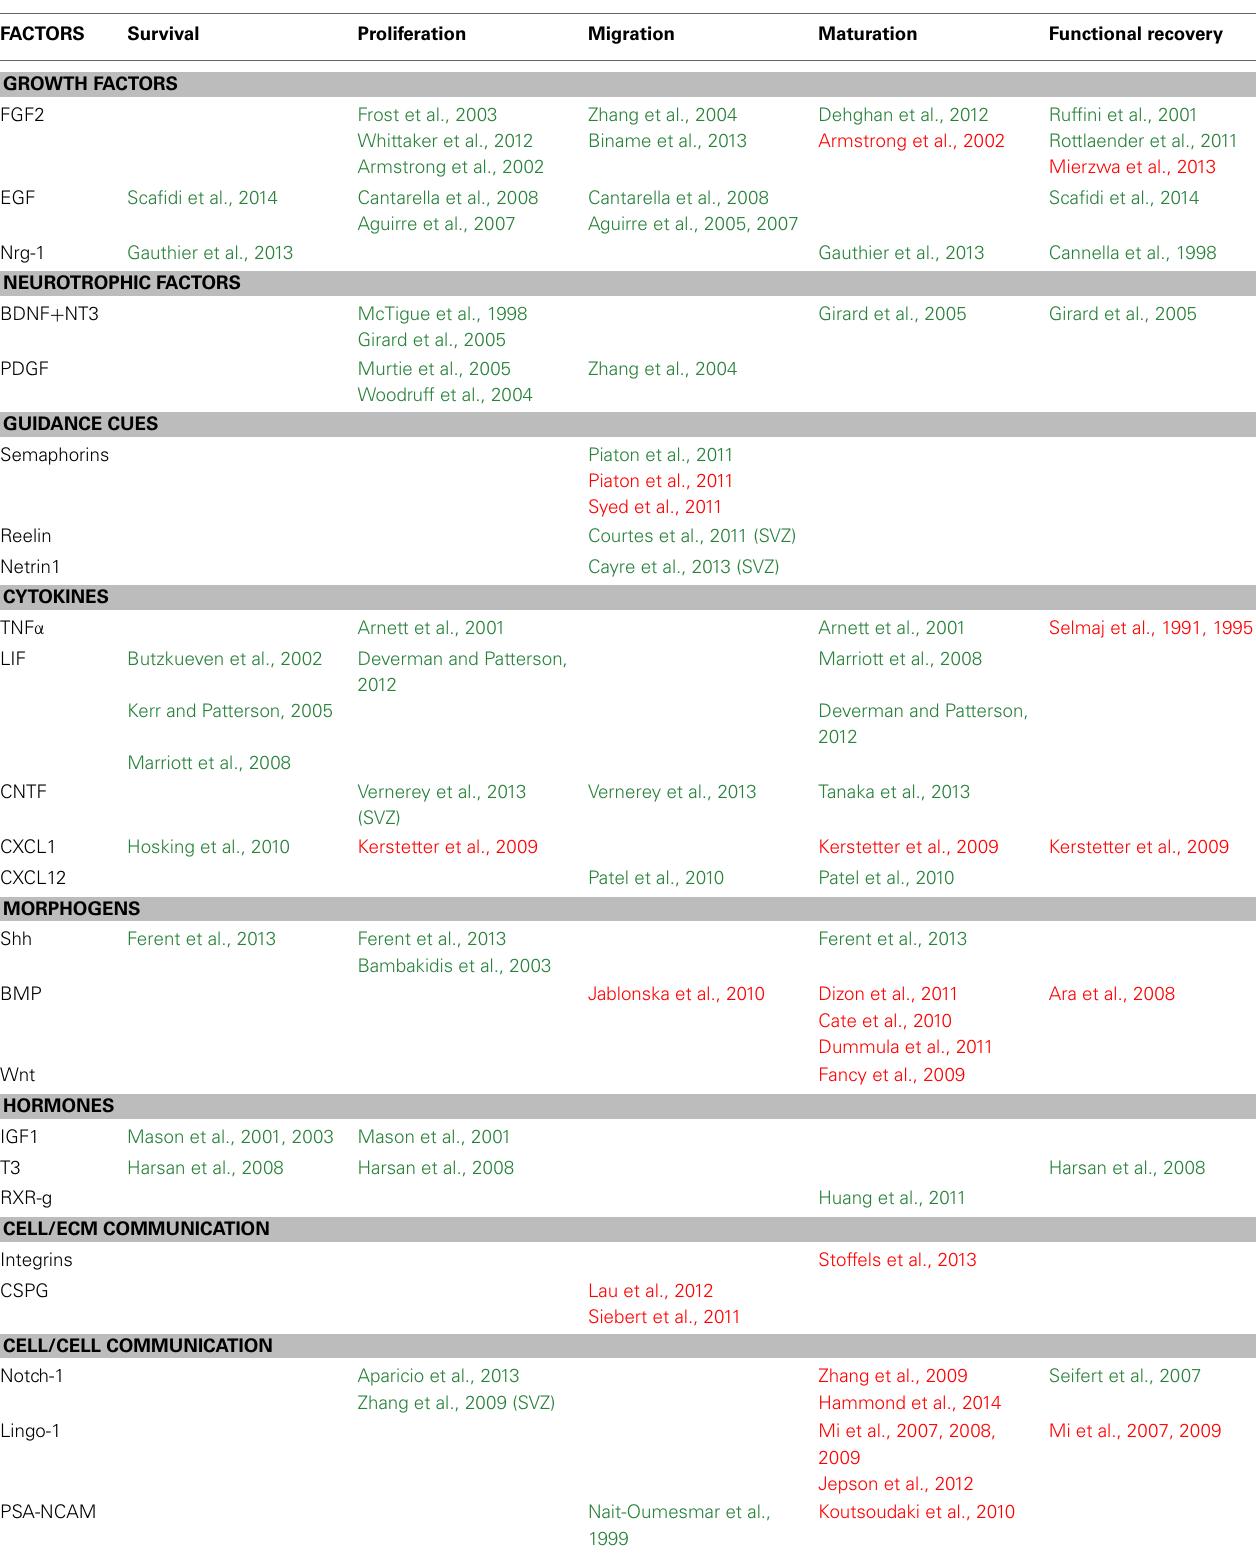
Table 1 | Factors controlling the various steps of the regenerative process in mouse models of